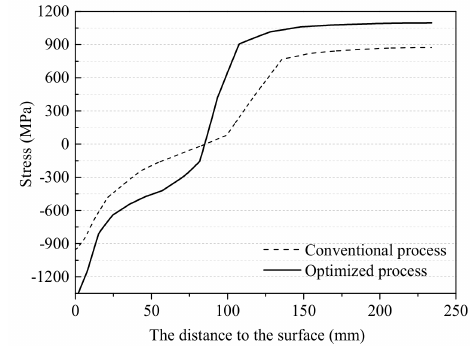
Figure 4. The residual axial stress distribution curves.